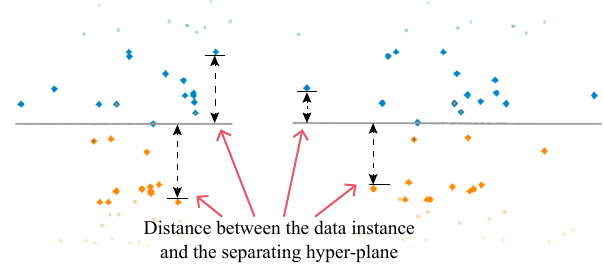
Fig. 7 Examples of a side